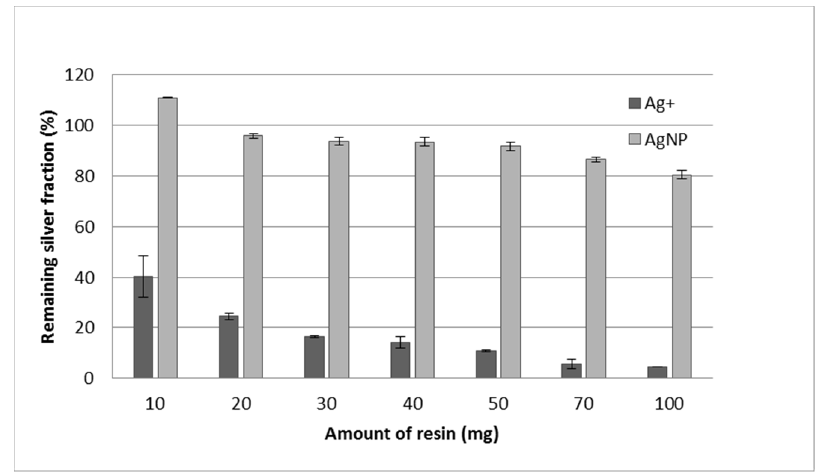
Figure 4. Remaining silver (Ag + or AgNPs) after 60 min of contact with the resin in sodium form using different amounts. Error bars represent standard deviation n = 2. Initial silver concentration is 100 μg·kg − 1 for both Ag + and AgNPs.